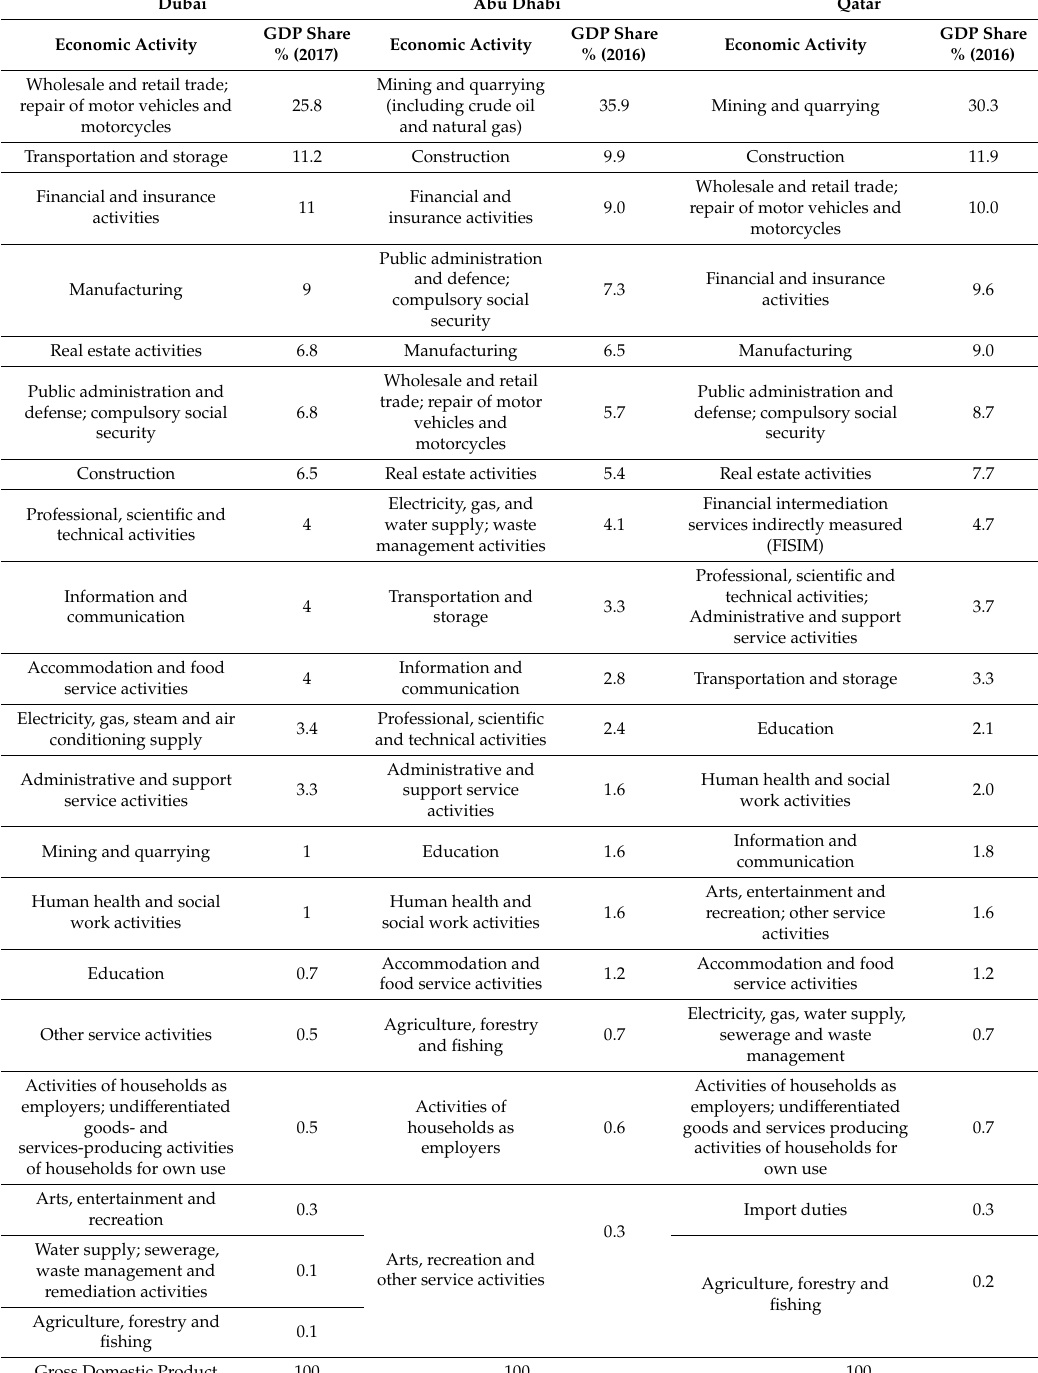
Table 3. Industrial diversification in Qatar, Abu Dhabi and